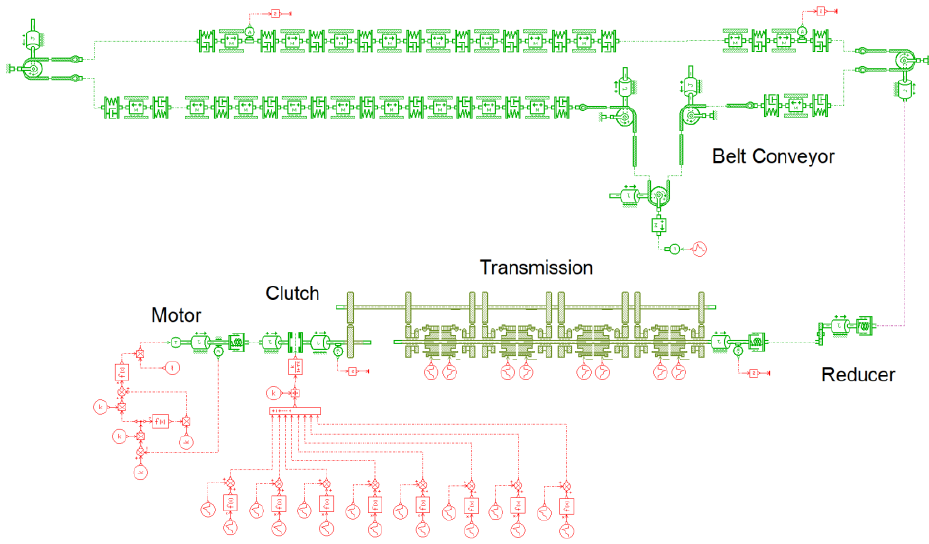
Figure 8. Simulation model based on AMESim. The belt conveyor is built according to Equations (10), (16), and (17) from Section 3.3. The upper and lower belts are divided into 10 parts separately. AMT model is composed